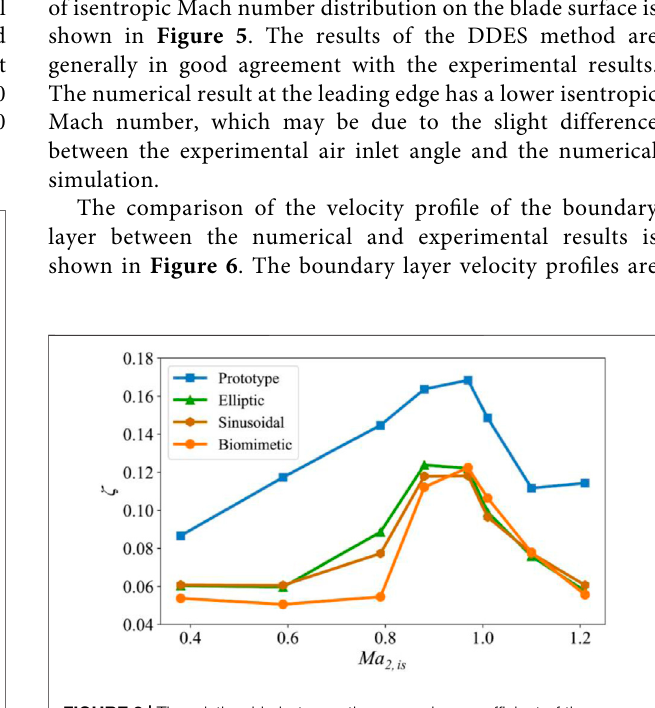
Frontiers in Energy Research |